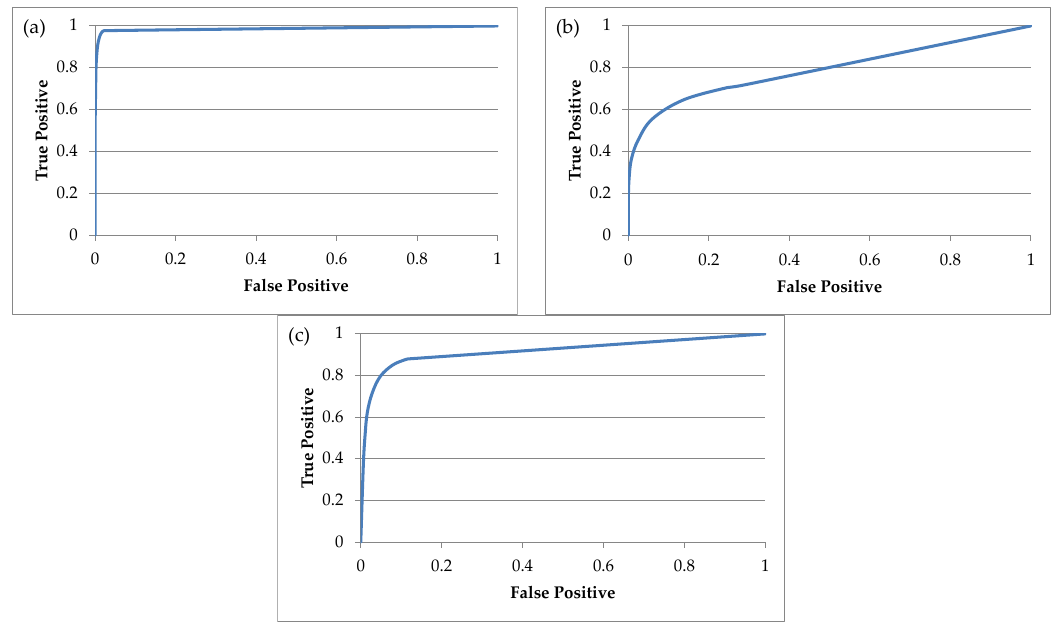
14 of 19 Table 4. Correct Classification Rate, False Rejected Rate and False Accepted Rate for scenarios: (c), (d) and (e). No. of Sub.